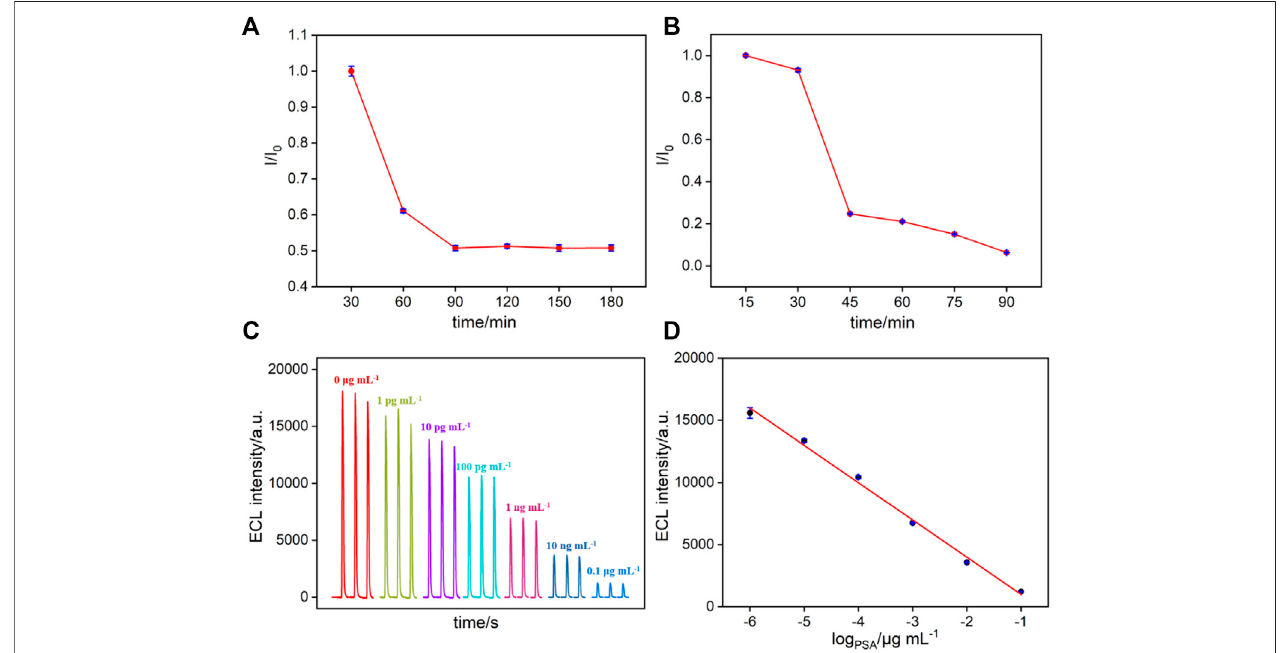
FIGURE5|(A – B) Theeffectofantibodyimmobilization (A) or (B) PSAincubationtime (B) onrelativeECLsignalratio. (C) ECLresponseoftheimmunosensorinthe presence of different concentrations of PSA. (D) Calibration curve for the detection of PSA.